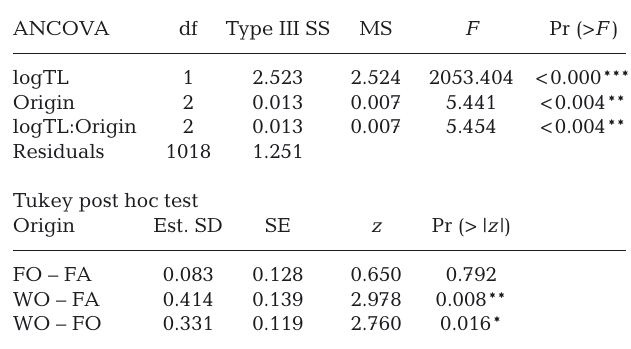
Table 3. ANCOVA model and Tukey post hoc tests for length− weight relationship slope differences between farm-associated (FA), farmed (FO) and wild (WO) Adriatic gilthead seabream. TL: total length. *p < 0.05, **p < 0.01, ***p <